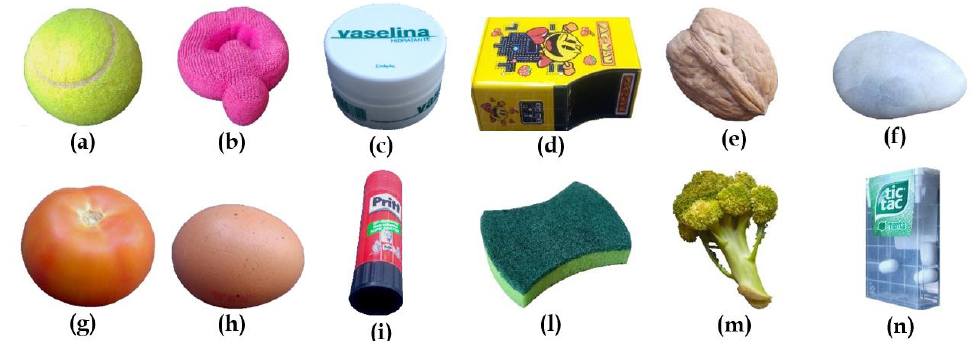
Figure 9. Selection of objects for experimentation with its identification number. ( a ) Tennis ball #1, ( b ) Screen Cleaner #2, ( c ) Vaseline Container #3, ( d ) Metallic Container #4, ( e ) Nut #5, ( f ) Rock #6, ( g ) Tomato #7, ( h ) Egg #8, ( i ) Glue Stick #9, ( l ) Dish Sponge #10, ( m ) Broccoli #11, and ( n ) Candy Box #12.